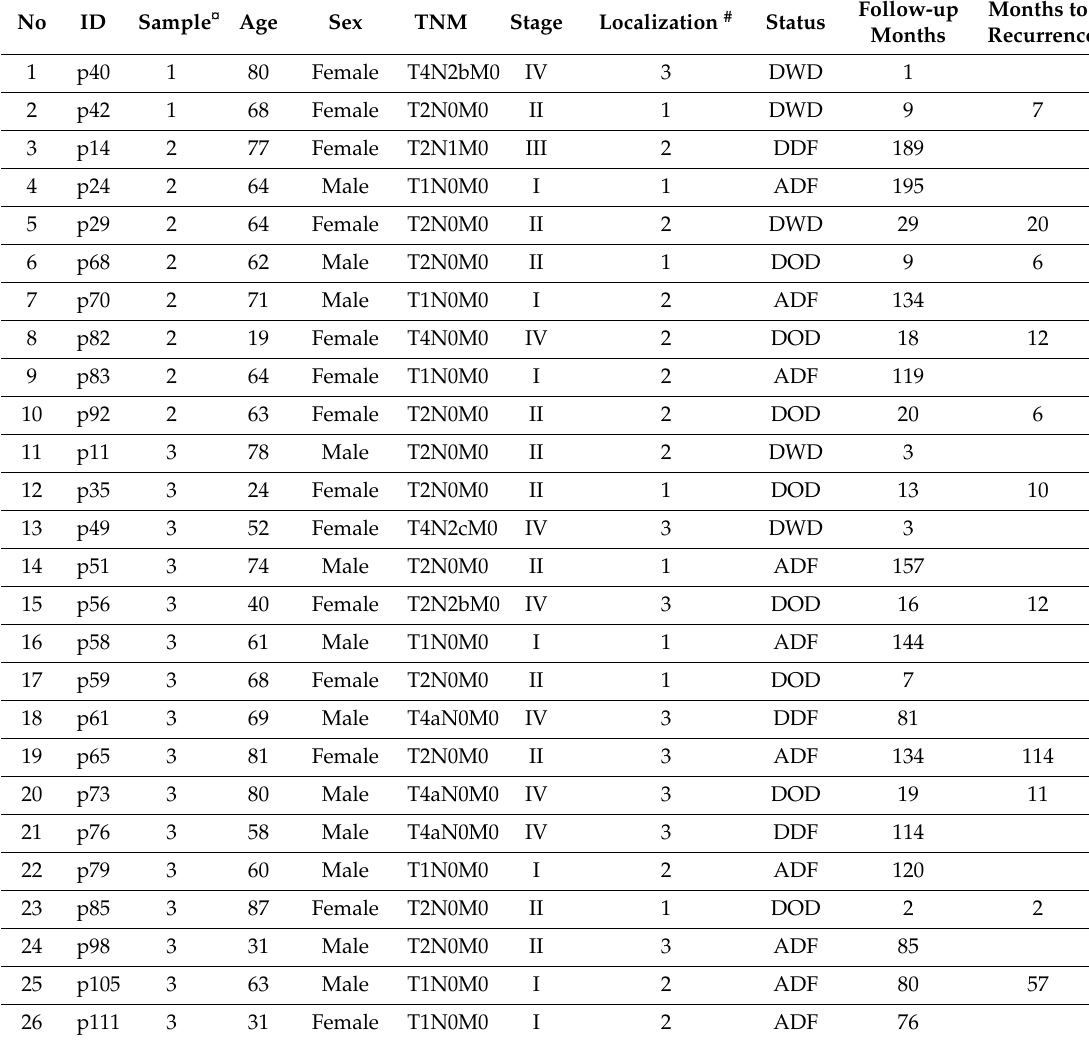
Table 6. Clinicopathological data on SCCOT patients and healthy